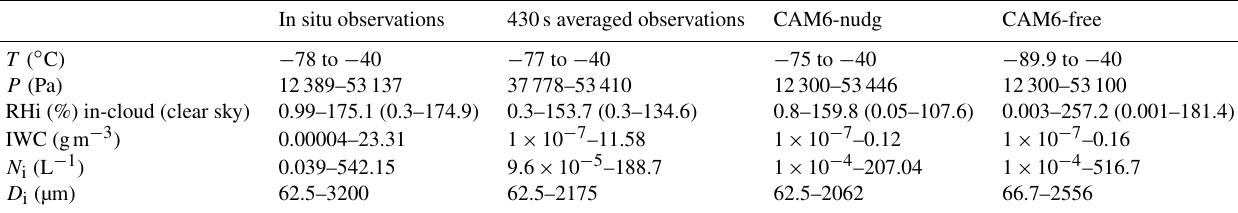
Table 2. Ranges of meteorological conditions and ice microphysical properties for in situ 1Hz observations, 430s averaged observations, CAM6-nudg and CAM6-free data used in this study. In situ